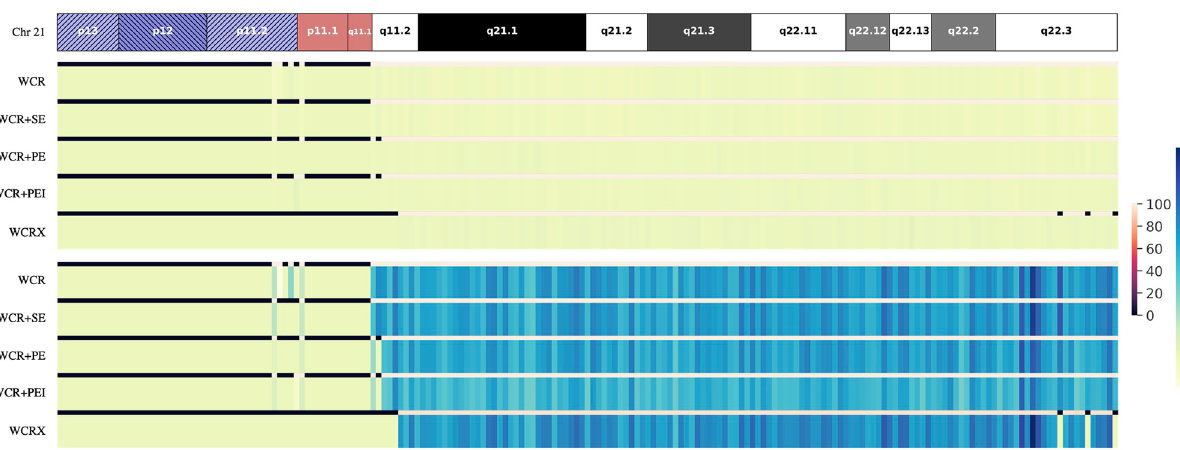
Fig 2. Per-bin Z-score relationship at 250 kb. Heatmaps of the summed per bin Z-scores across all negative (top) and all T21 positive (bottom) samples at a 250 kb bin scale for chromosome 21 and all different Wisecondor-based methods. The line above each method’s heatmap corresponds to the average number of selected reference bins for each bin of that method (black denoting that no similar reference bins are found and consequently these bins are excluded).